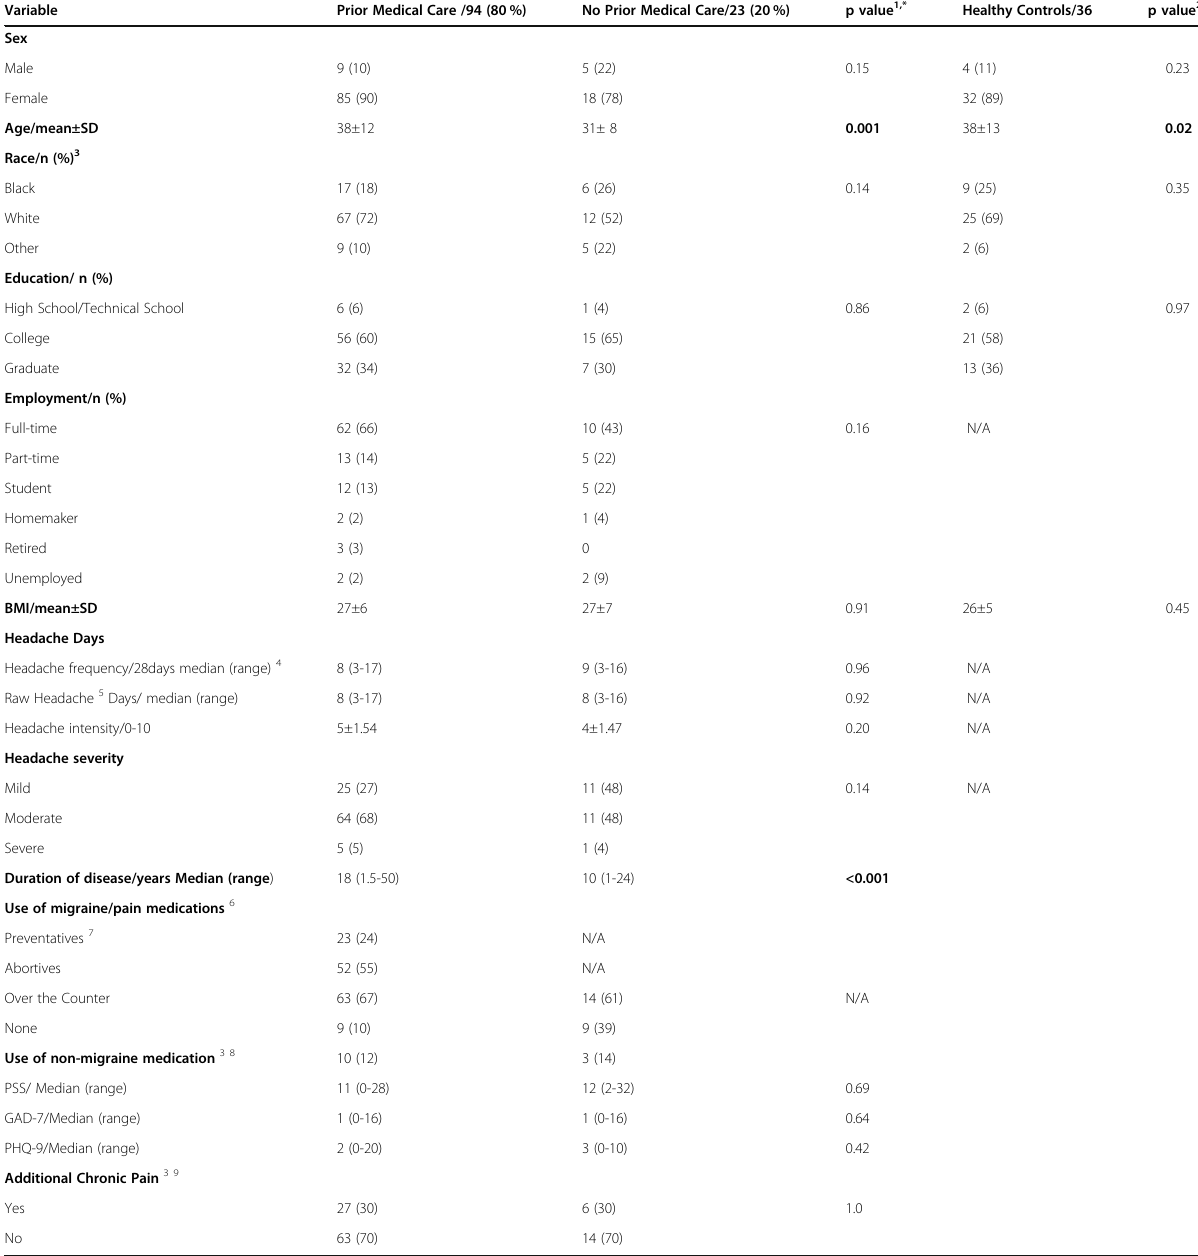
Table 1 Sociodemographic and clinical factors in EM patients with and without prior clinical care for migraine and healthy controls Variable Prior Medical Care /94 (80%) No Prior Medical Care/23